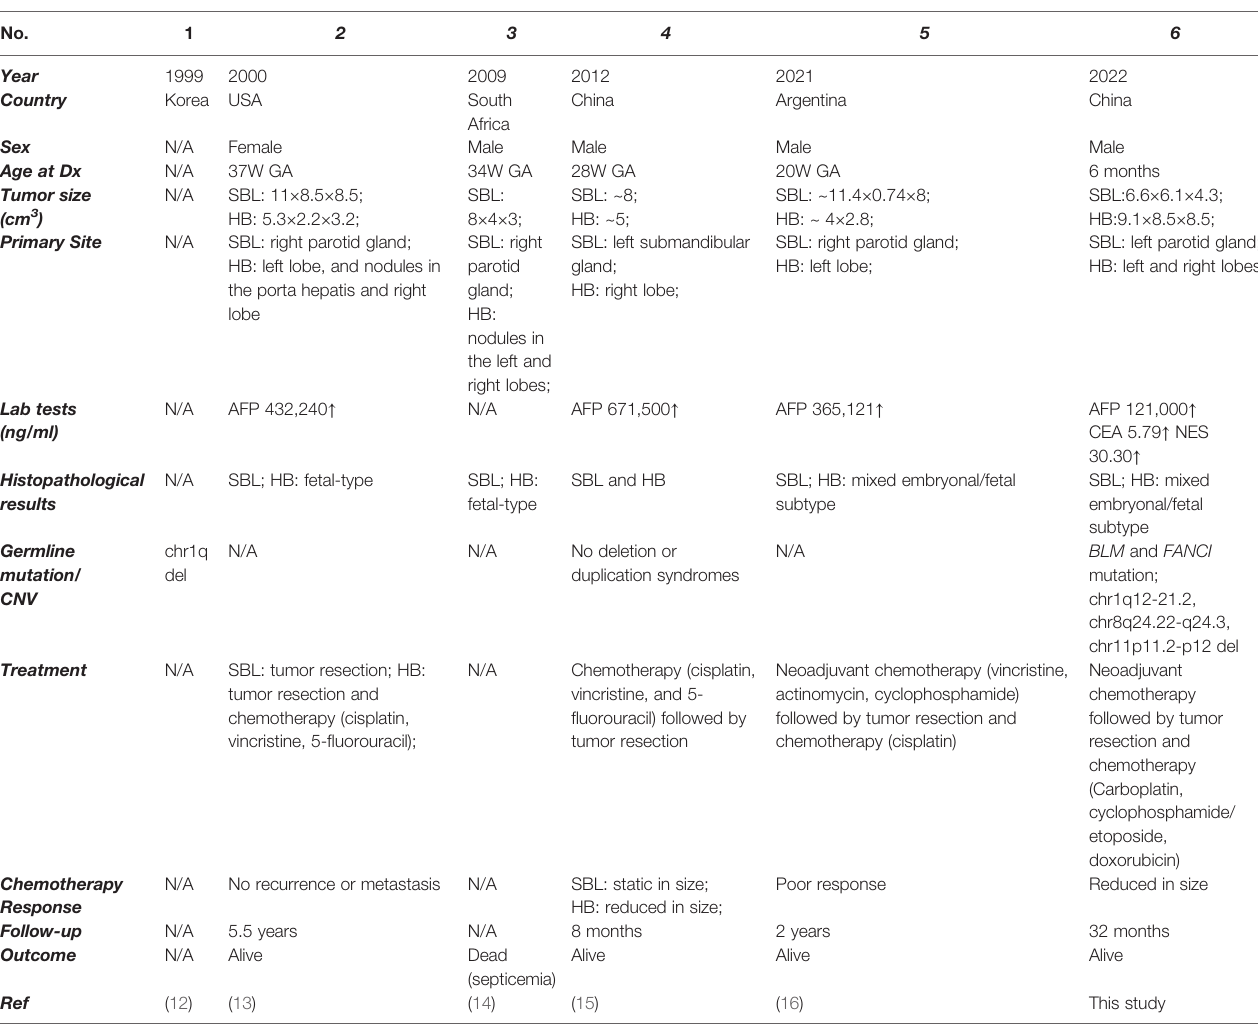
↑ , elevated level of tumor markers; N/A, not